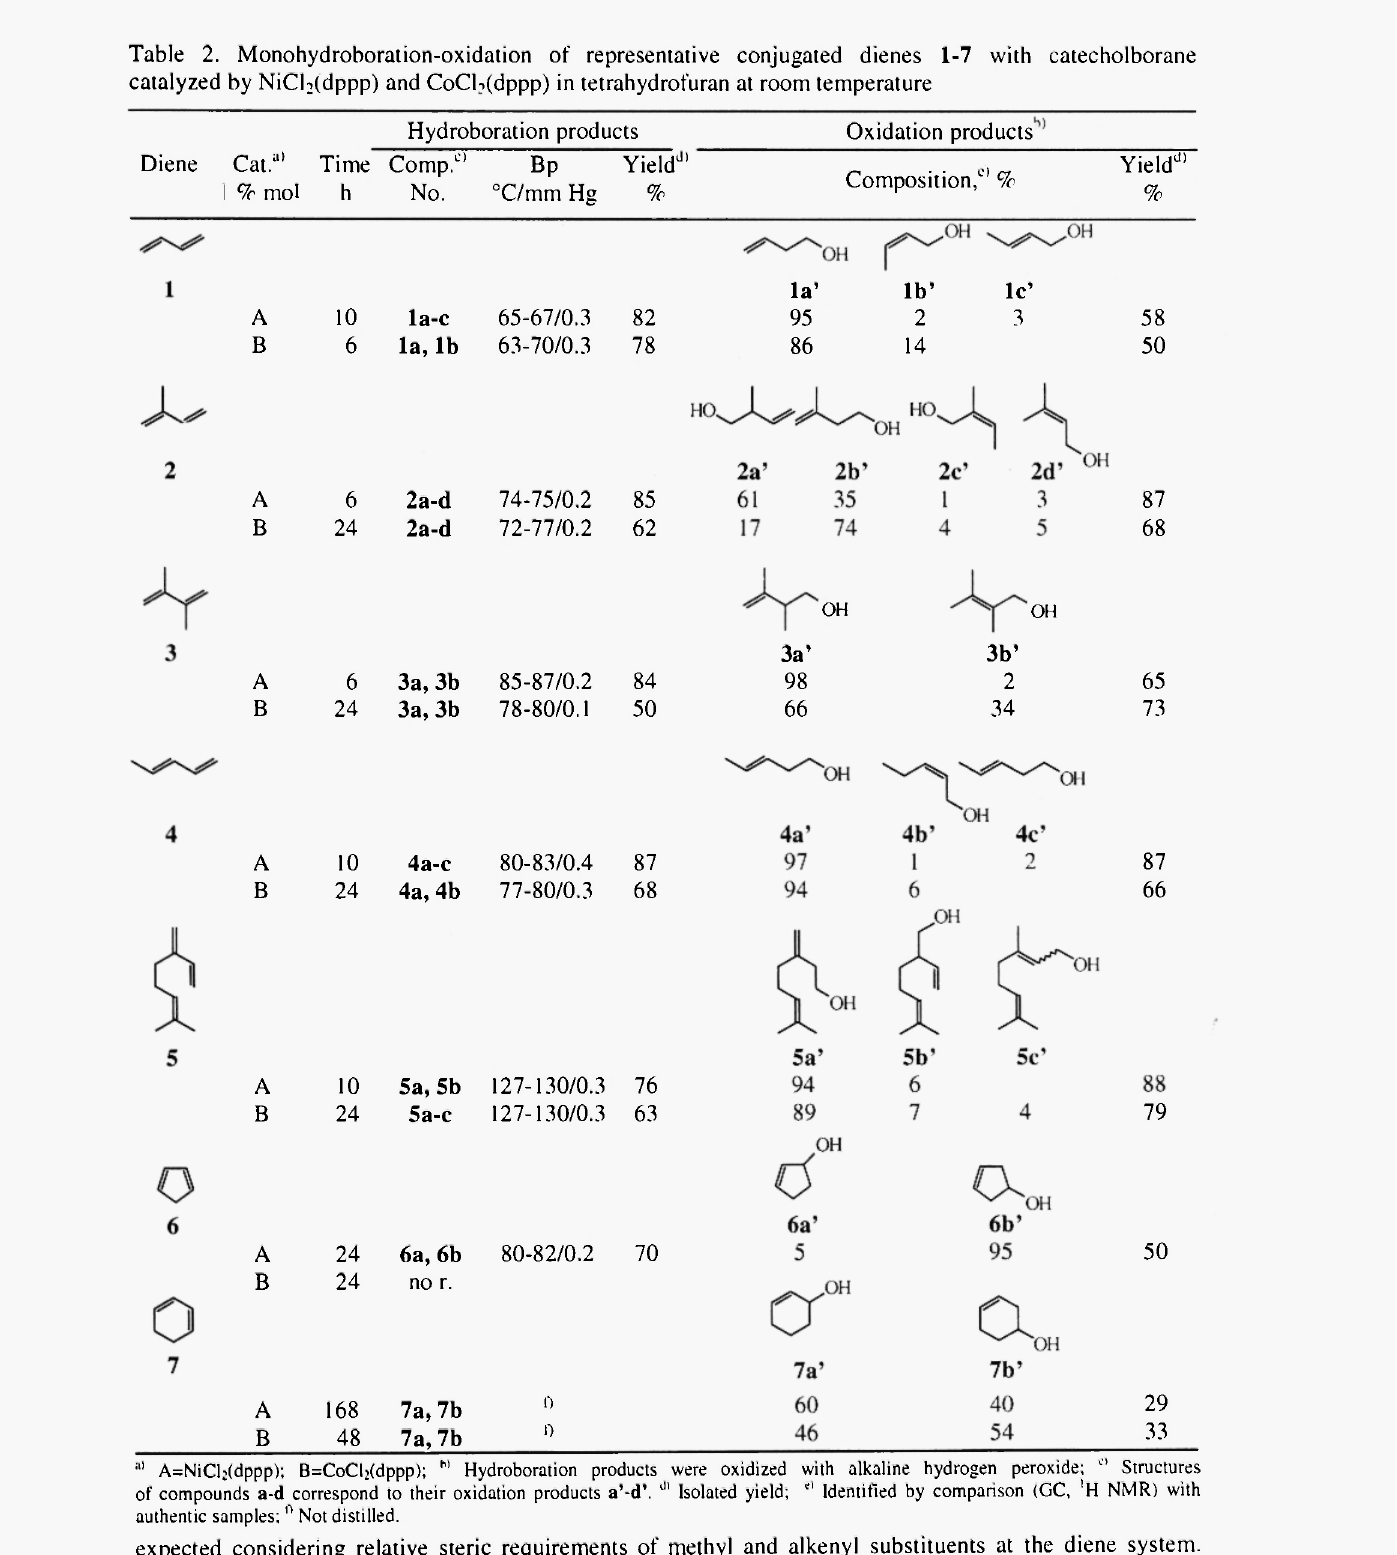
Table 2. Monohydroboration-oxidation of representative conjugated dienes 1-7 with catecholborane catalyzed by NiCl 2 (dppp) and CoCUCdppp) in tetrahydrofuran at room temperature Hydroboration products Oxidation Diene "Yield Jl